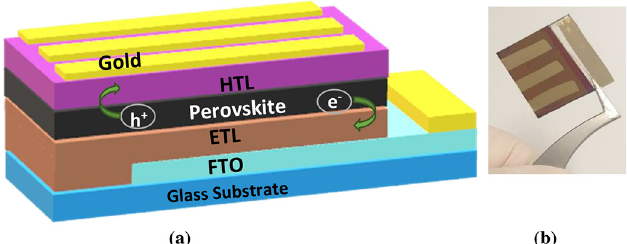
Fig. 2. (a) Schematic structure of the PvSC and (b) photo of the perovskite cell fabricated in this work.